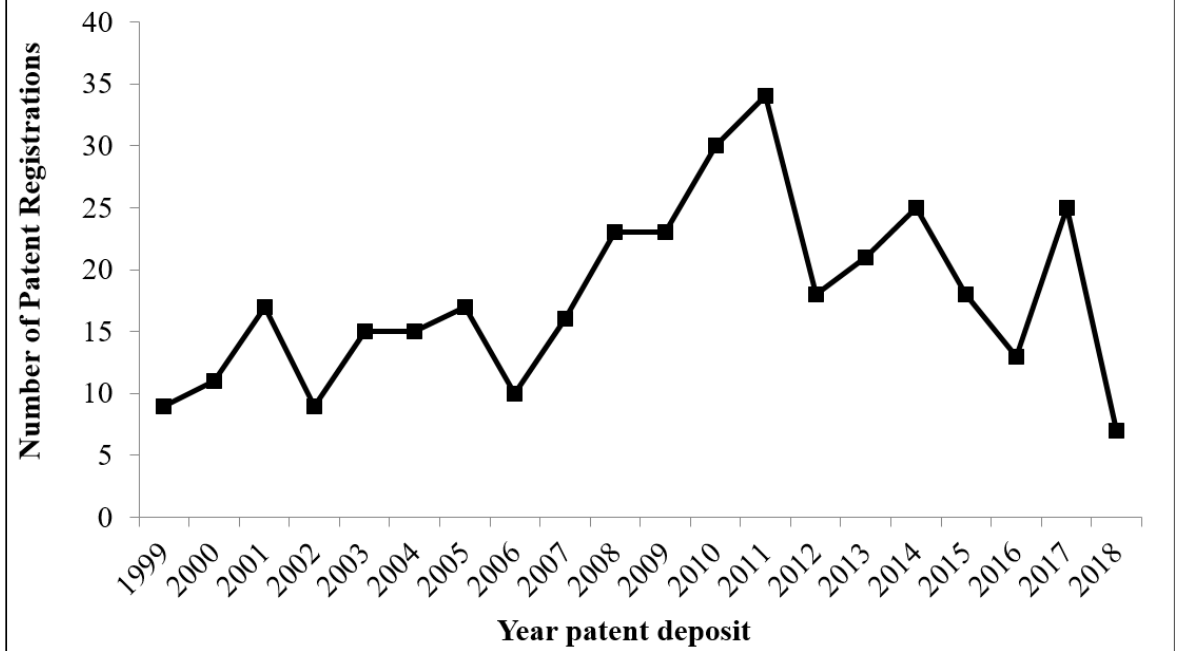
Figure 1. Annual evolution of patent applications relating to fisheries resources and respective areas of application located in the INPI